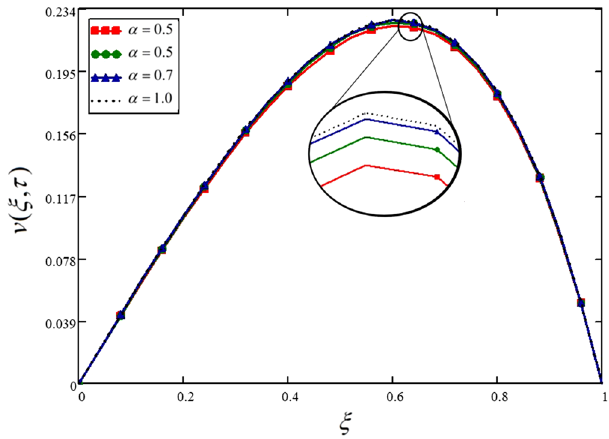
Figure 2. Influence of the fractional parameter on the nanofluid